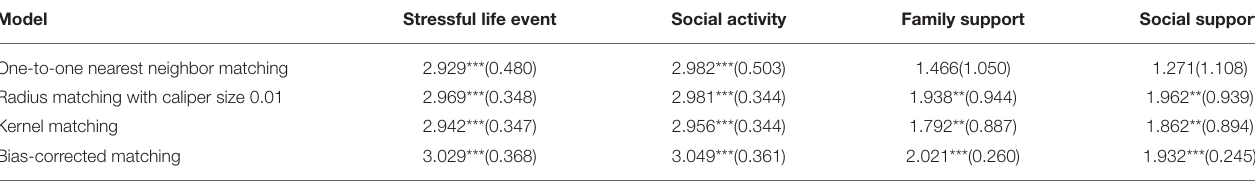
TABLE 3 | Results from propensity score matching (PSM) and bias-corrected matching from stressful life events and social support predicting depression.